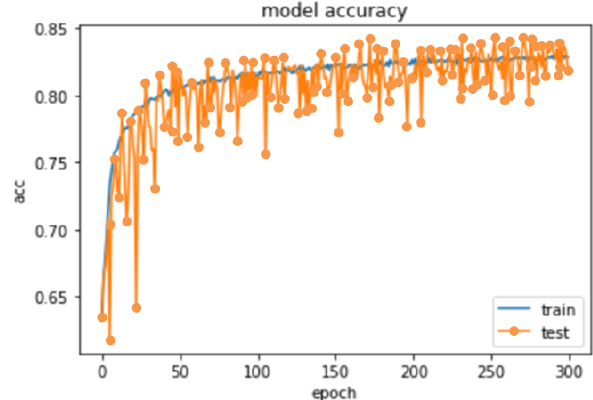
Figure 6. The training accuracy quality of the double-layer ANN for the two classes for the set of indicators from the ATC profile widths at levels of 10%, 30%, 50%, 70% and 90% of the maximum ampli- tude value and maximum